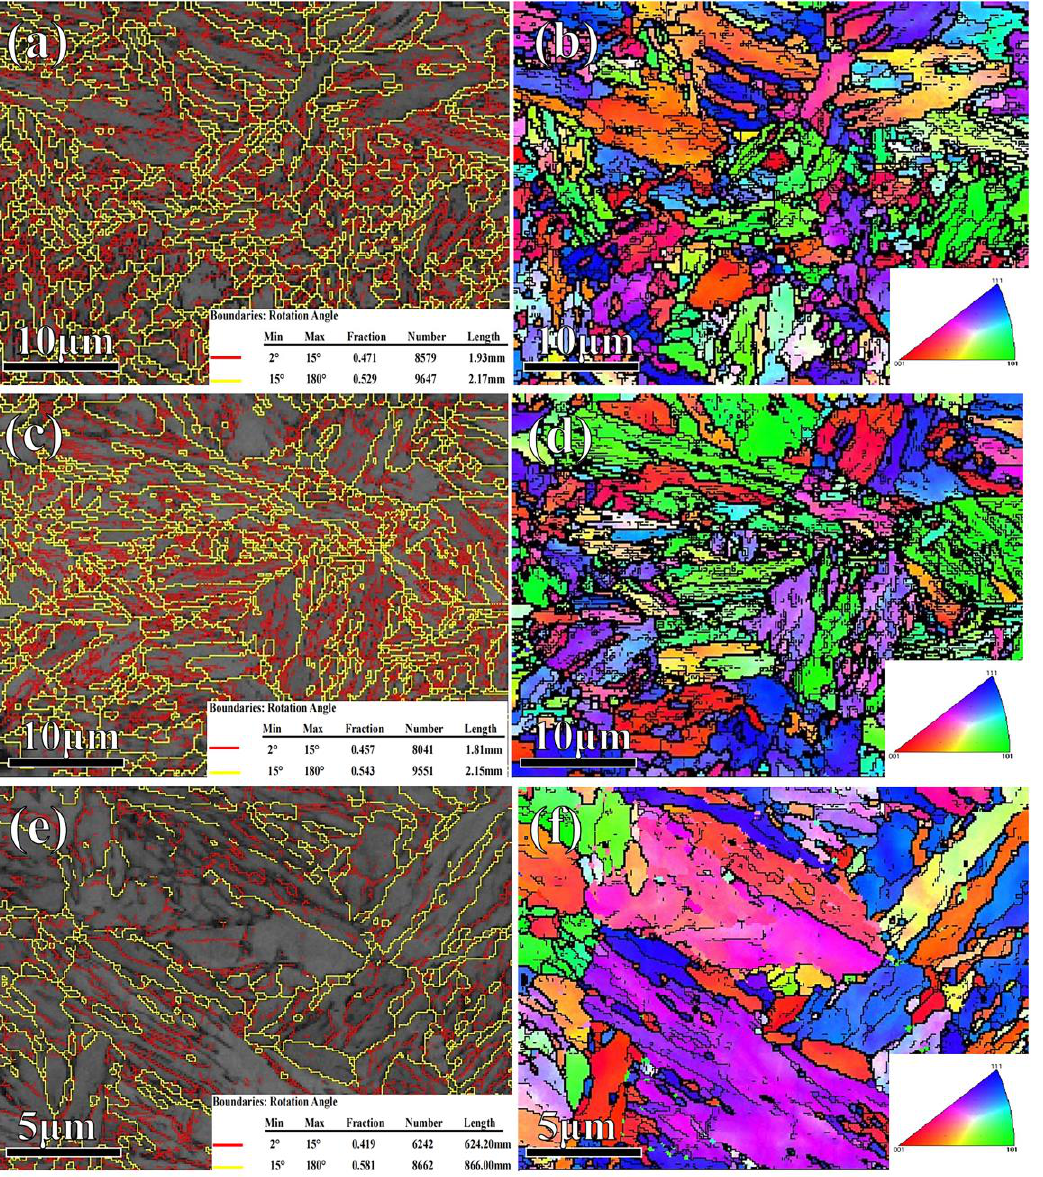
Figure 9. EBSD test: ( a , b ) metallographic, polar, and IPF images of the P300 sample; ( c , d ) metallo- graphic, polar, and IPF images of the P260 sample; ( e , f ) metallographic, polar, and IPF images of the P240 sample.